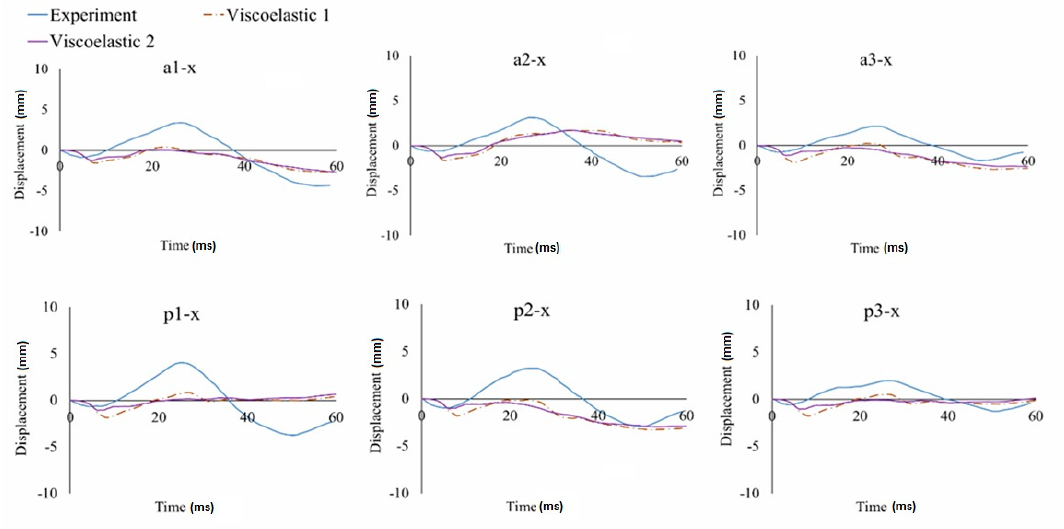
Figure 3. Displacement-in-time characteristics of the markers in the frontal (a) and rear columns (p) in the X-direction using the viscoelastic material models approach.